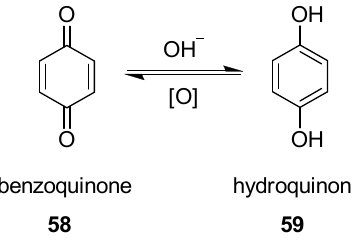
Figure 3. Schematic of the chemical reaction of marine mussel catechol and the combined reactions of oxidative decarboxylation and redox catalysis of quinone-catechol used to form the lignin-based adhesive antimicrobial hydrogel. AgNPs = silver nanoparticles; APS = ammonium persulfate; PAA = poly (acrylic acid) (Reprinted with permission from ref. [66]). Copyright 2020, American Chemical Society).